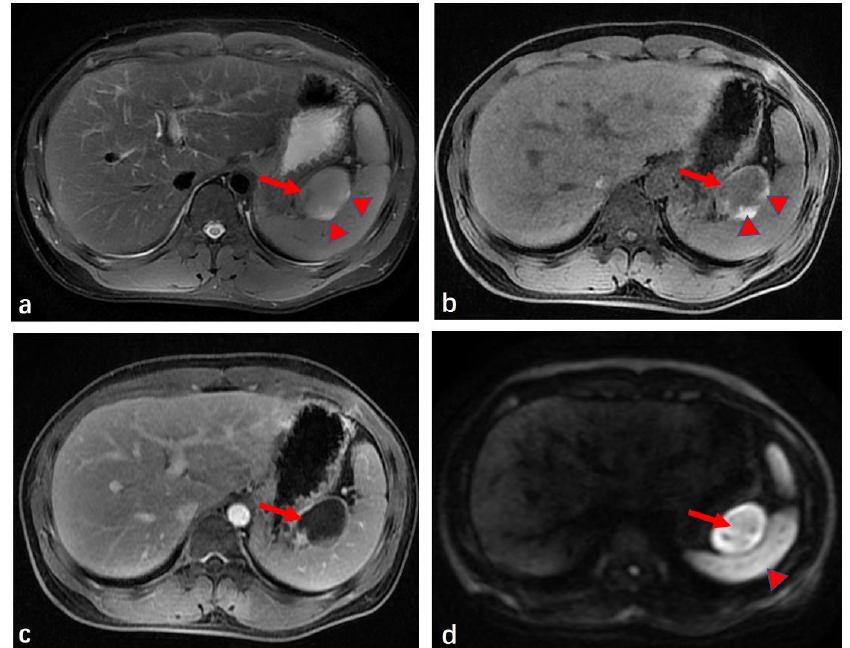
Figure 3. Magnetic resonance imaging of the patient’s abdomen. ( a ): T2WI shows a slightly hyperintense mass (red arrow) with some hyperintense areas (red arrowheads). ( b ): T1WI shows a homogeneous, hypointense mass (red arrow) with a thin peripheral hyperintense rim and some hyperintense areas (red arrowheads), similar to T2WI. ( c ): T1WI postgadolinium shows circular enhancement. ( d ): The DWI signal was significantly stronger (red arrow) than that of the spleen (red arrowhead).